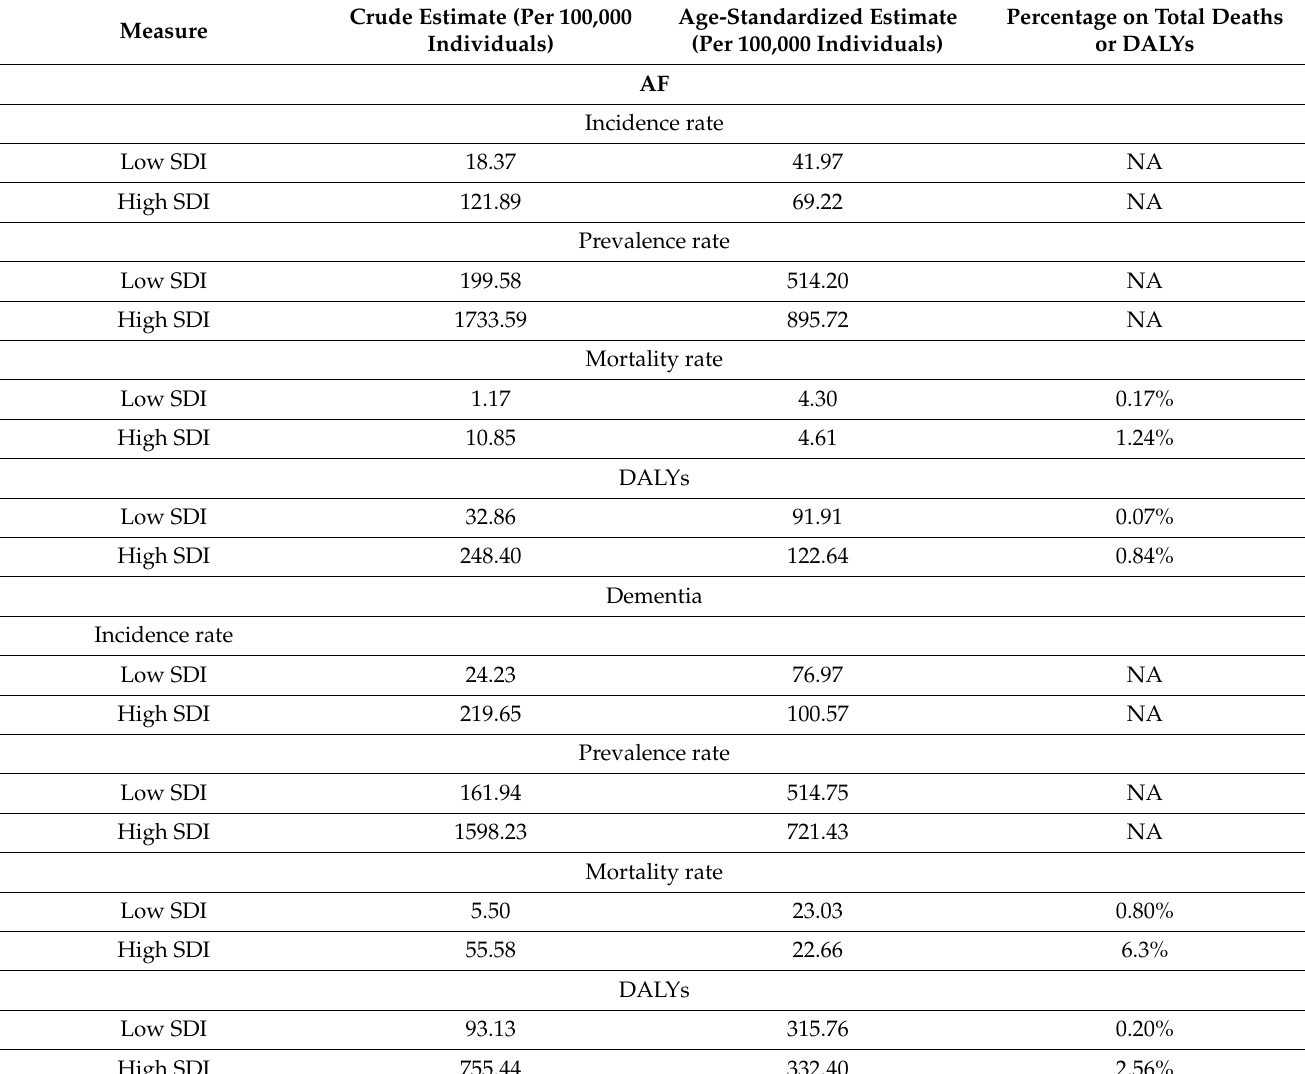
Table 2. Focus on 2019 epidemiological metrics of atrial fibrillation and dementia in low and high SDI countries estimated by the GBD